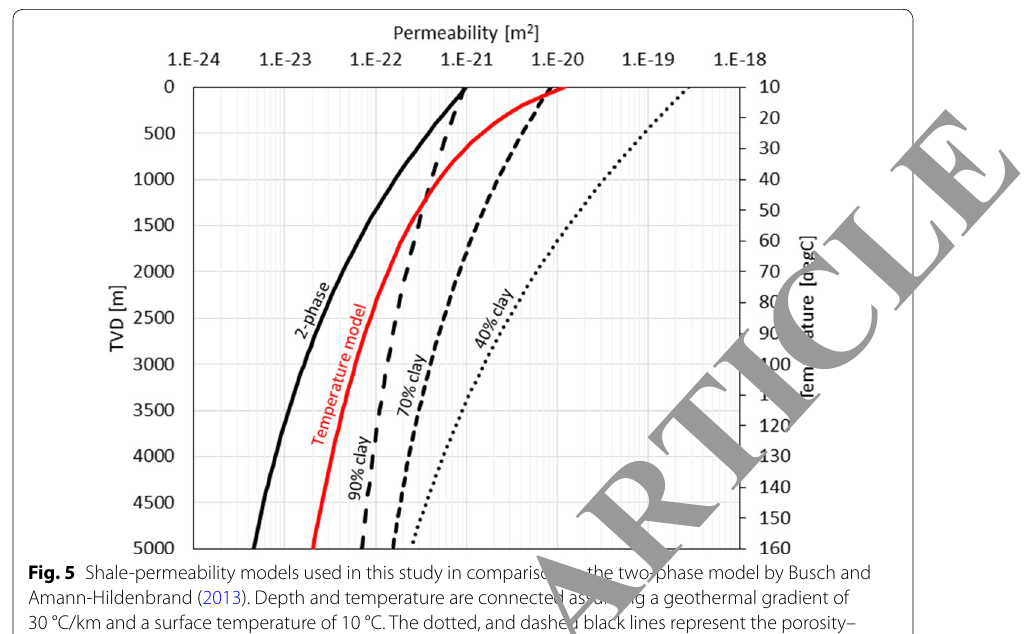
Fig. 5 Shale-permeability models used in this study in comparison to the two-phase model by Busch and Amann-Hildenbrand (2013). Depth and temperature are connected assuming a geothermal gradient of 30 °C/km and a surface temperature of 10 °C. The dotted, and dashed black lines represent the porosity– permeability relationships from Yang and Aplin (2010) for 40%, 70% and 90% clay content, respectively. Porosity has been modeled using the porosity function of Drews et al. (2018) also used in this study. The temperature-dependent permeability model developed in this study is represented by the solid red line. The two-phase permeability model (solid black line) is derived from application of the model of Busch and Amann-Hildenbrand (2013) to the porosity–permeability relationship of Yang and Aplin (2010) for 70% clay